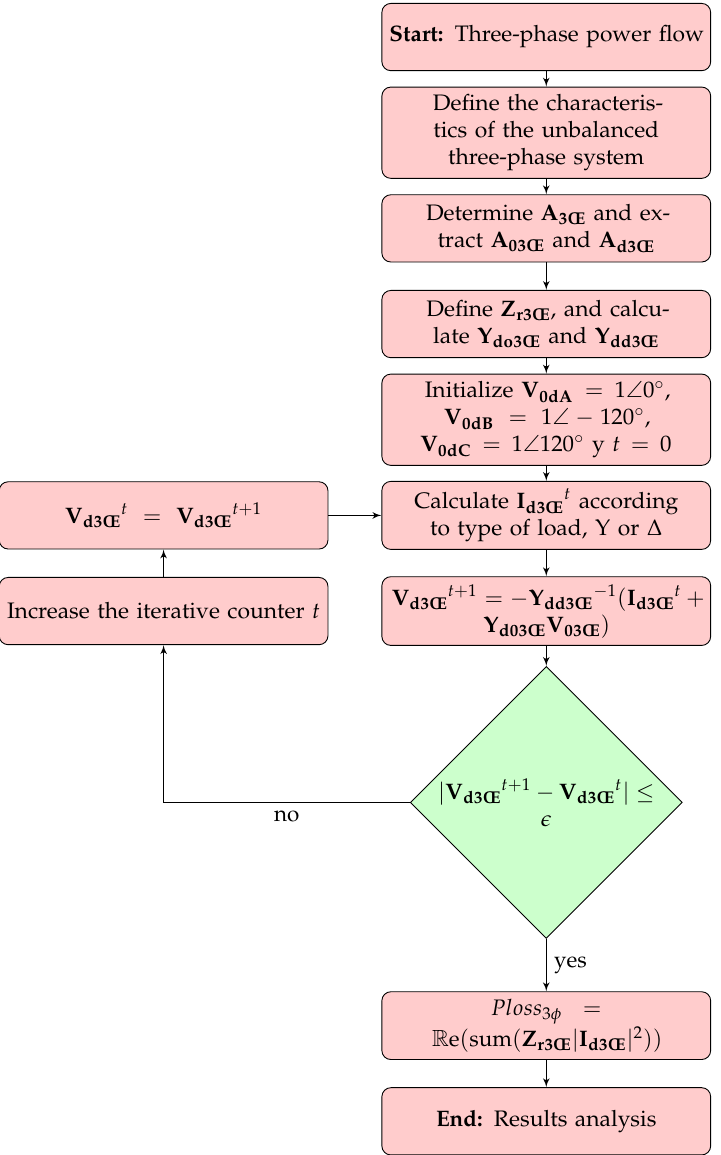
Figure 5. Flow diagram of the three-phase iterative sweep method used in the slave stage of the methodology